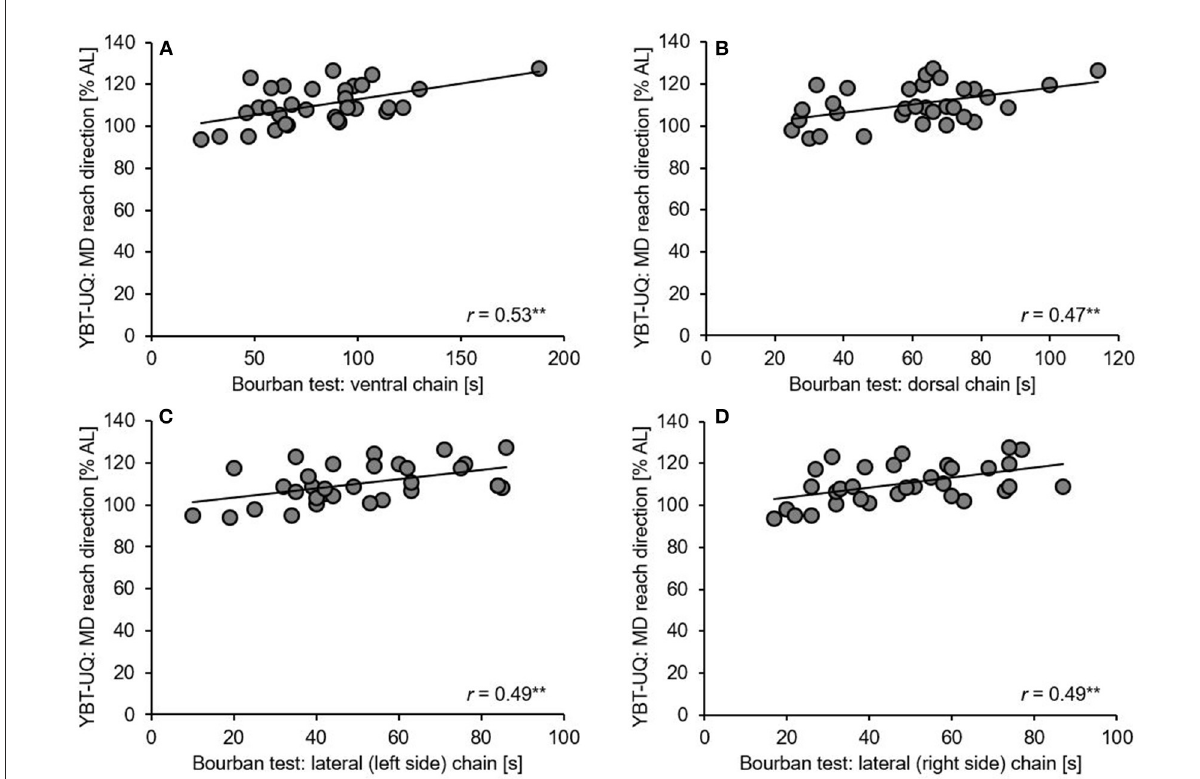
FIGURE4 Pearson‘s correlations between the medial (MD) reach direction of the Upper Quarter Y-Balance (YBT-UQ) test and the (A) ventral, (B) dorsal, (C) lateral (left side), and (D) lateral (right side) chain of the Bourban test. **correlation is significant at the 0.01 level